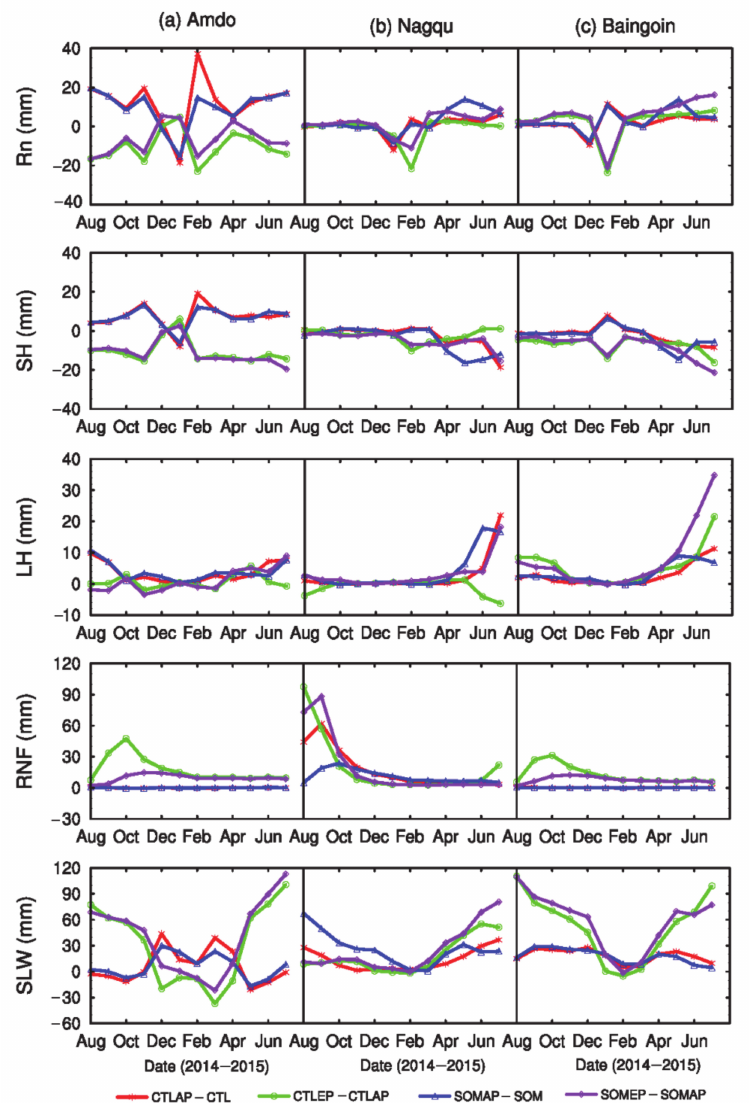
Figure 11. The monthly di ff erences in simulated hydrological cycles for the selected optimal scheme combination resulting from di ff erent precipitation datasets at the ( a ) Amdo site, ( b ) Nagqu site, and ( c ) Baingoin site; subfigures from top to bottom show the monthly di ff erences in Rn, SH, LH, RNF, and 0–1 m total SLW,